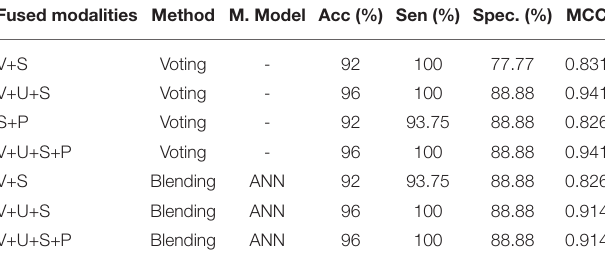
TABLE 12 | Performance offered by the proposed multimodal approach using SP